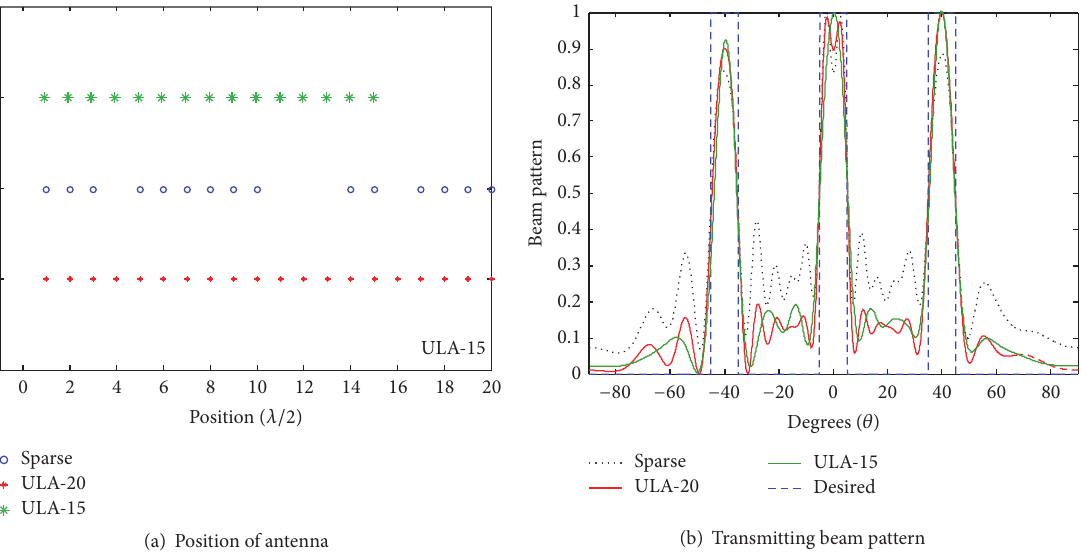
Figure 2: Results of SQP+GA in [8, 9].